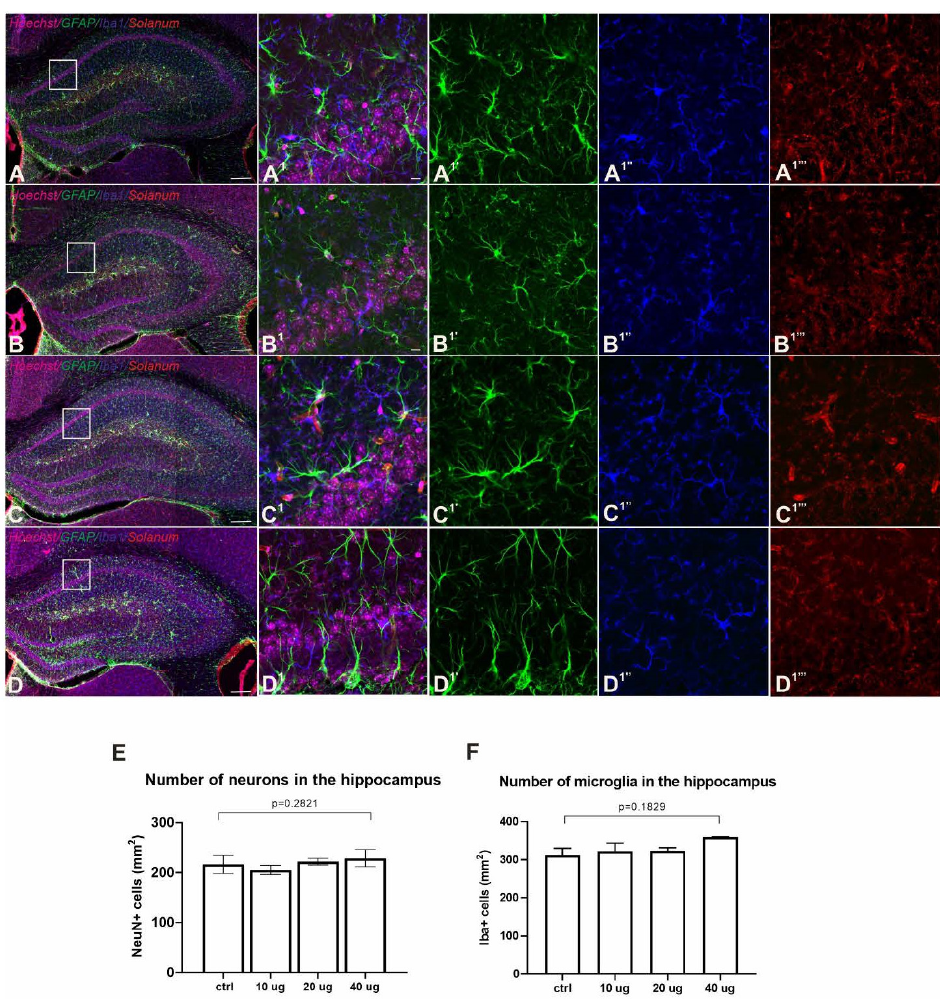
Figure 4. Lack of adverse side effects in the nervous system of immunized mice. ( A – D and A 1 – D 1 ) Fluorescence immunohistochemistry showed no accumulation in GFAP (green, astrocytes, ( A 1 ′ – D 1 ′ )), Iba1 (blue, microglia, ( A 1 ″ – D 1 ″ )) and Solanum tuberosum lectin (red, vasculature, ( A 1 ‴ – D 1 ‴ )) distribution between control ( A ) and Addavax™-/’VieVac’-injected animals (( B ) 10 µg, ( C ) 20 µg, ( D ) 40 µg). ( E , F ) Quantitative analysis of neuronal numbers (NeuN; ( E )) and Iba1-positive microglia ( F ) in the hippocampus (CA1 subfield) showed no difference between the control and vaccinated groups. Scale bars = 200 µm ( A – D ), 10 µm ( A 1 ′ – D 1 ‴ ).